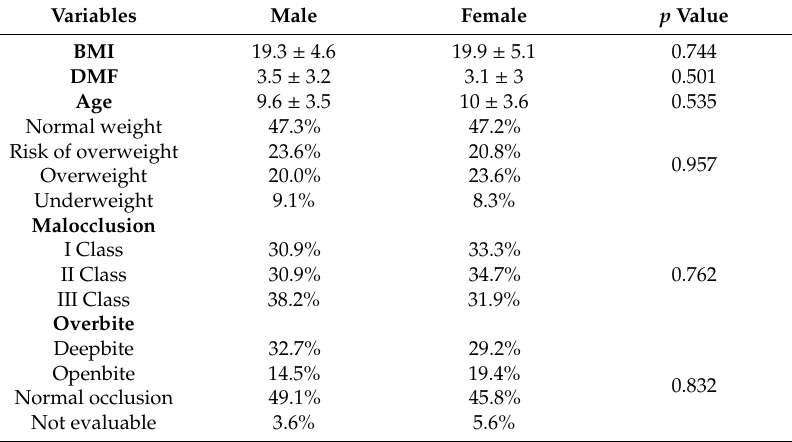
Table 19. Demographic and clinical variables of patients according to